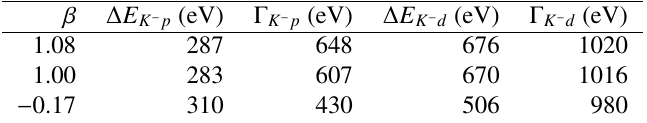
Table 3. Level shifts and decay widths of kaonic hydrogen and deuterium computed with di ff erent I = 1 strengths of the ¯ KN interaction. The experimental level shift data of kaonic hydrogen is ( ∆ E K (cid:0) p ; (cid:0) K (cid:0) p ) = (283 (cid:6) 36 (cid:6) 6, 541 (cid:6) 89 (cid:6) 22) eV [9, 10]. The numerical data are taken from Ref.